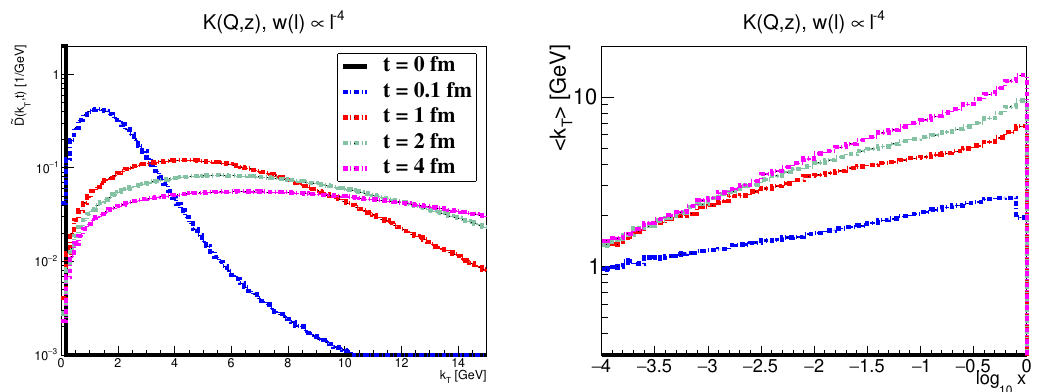
Figure 1 . The k T and h k T i vs. log x distributions for the evolution time values t = 0 , 0 . 1 , 1 , 2 , 4 fm, 10 for the full emission kernel K ( Q , z, p + ) (denoted as K(Q , z) ) and the collision term of eq.